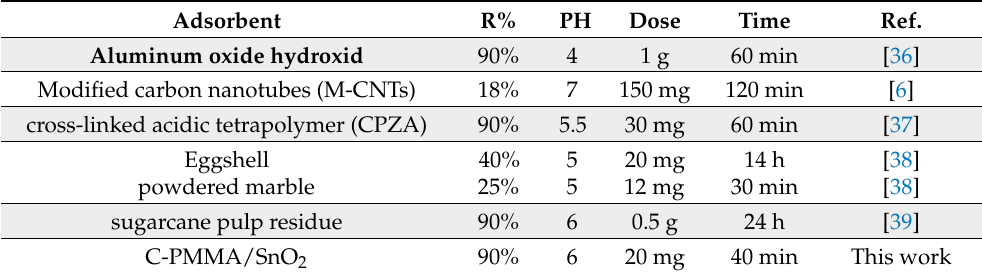
Table 5. Comparison of the adsorption efficiency of C-PMMA/SnO 2 and the adsorption efficiencies of various adsorbents for Cr (III). Adsorbent R% PH Dose Time Aluminum oxide hydroxid 90% Modified carbon nanotubes (M-CNTs) 18% cross-linked acidic tetrapolymer (CPZA) Eggshell powdered marble sugarcane pulp residue C-PMMA/SnO